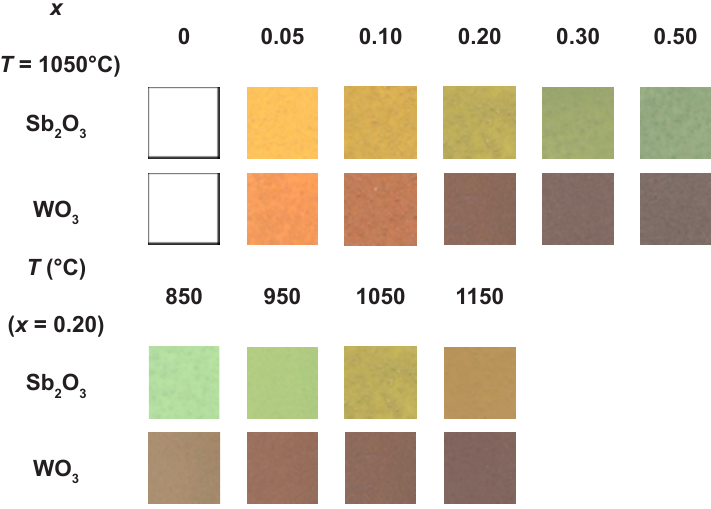
Figure 3. Color card of obtained pigments applied to organic matrix in mass tone.